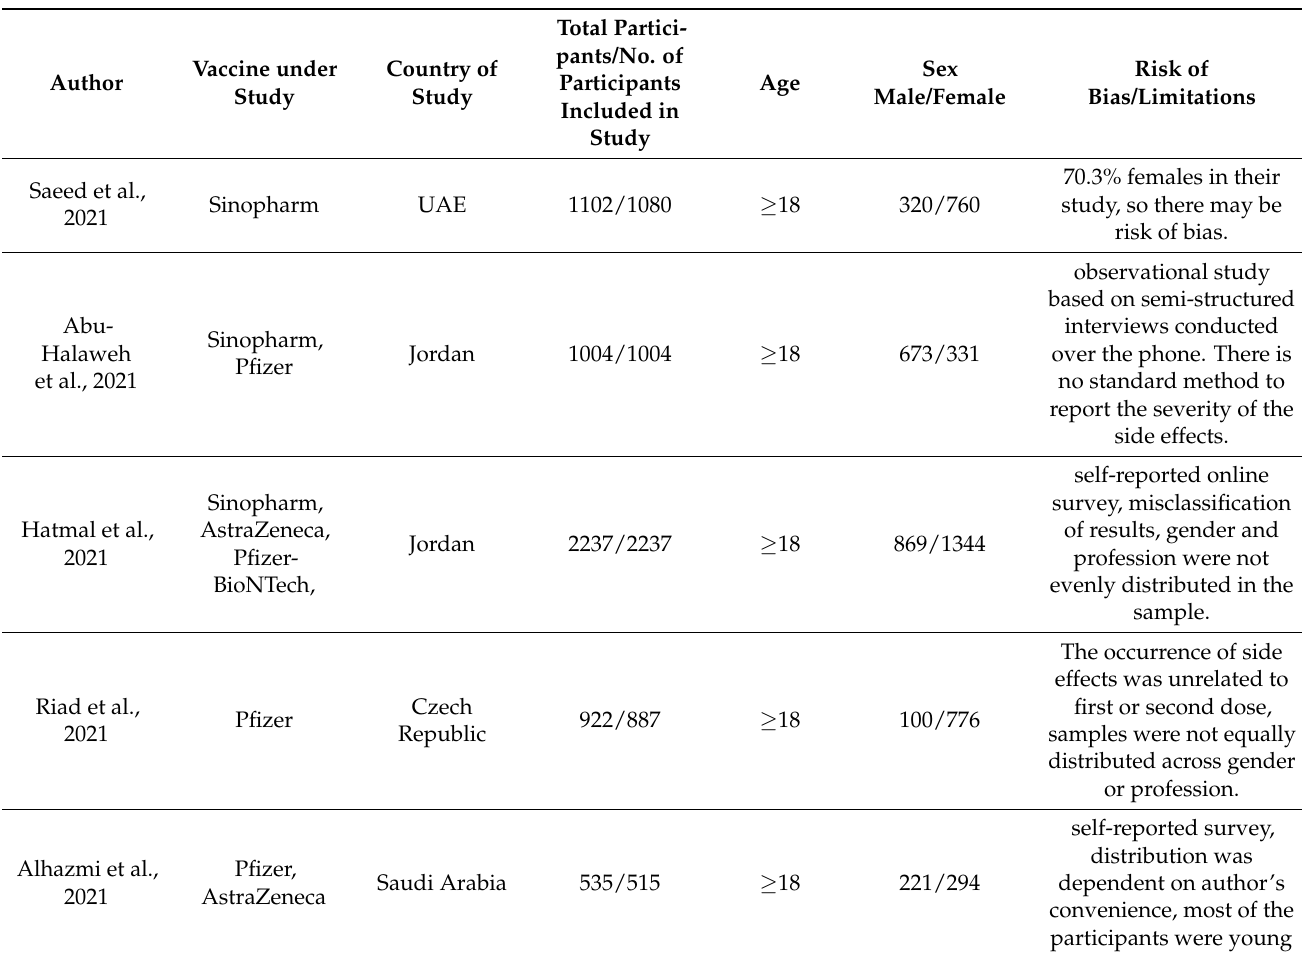
Table 2. Comparison of different studies showing side effects of COVID-19